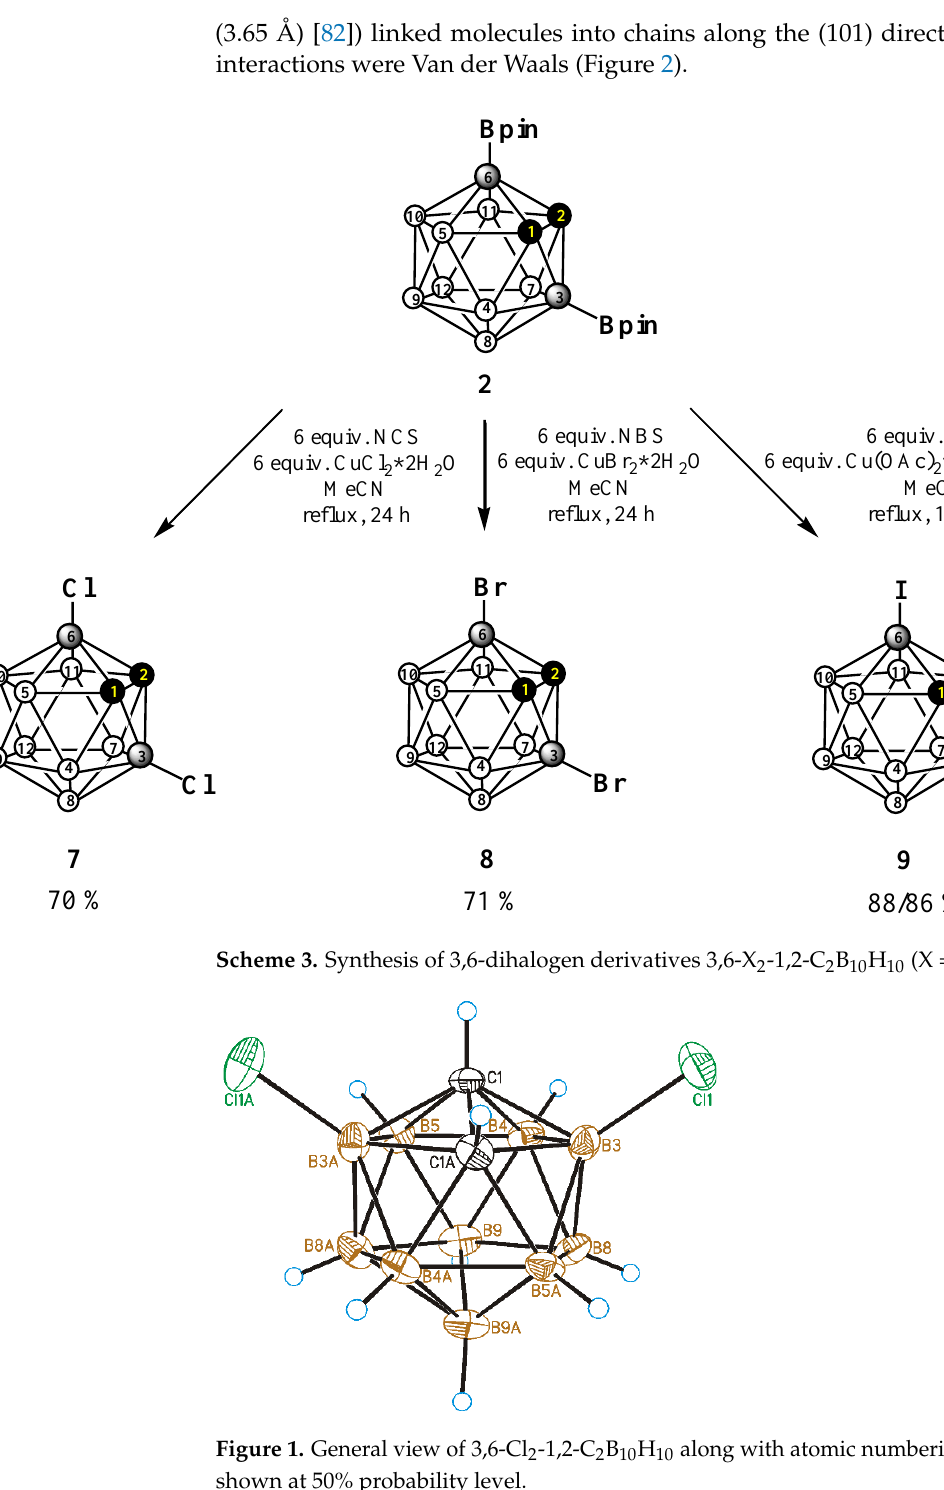
Figure 1. General view of 3,6-Cl 2 -1,2-C 2 B 10 H 10 along with atomic numbering. Thermal ellipsoids are shown at 50% probability level.